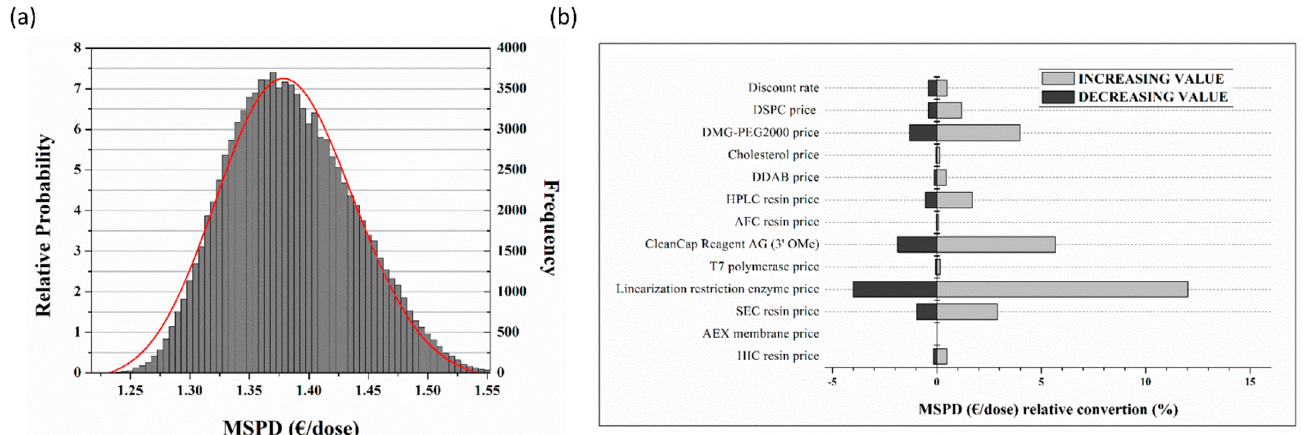
Figure 9. MSPD Monte-Carlo related data ( a ) Complex factorial, relative probability density function of MSPD against relative probability and Monte-Carlo frequency occurrence; ( b ) relative conversion against baseline scenario for the participating process wide raw materials.